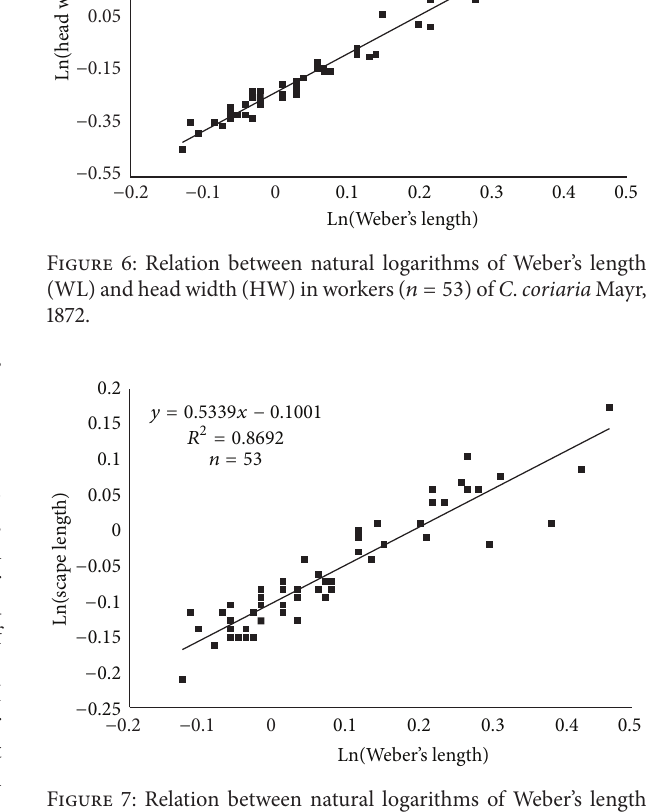
Figure 7: Relation between natural logarithms of Weber’s length (WL) and scape length (SL) in workers ( 𝑛 = 53 ) of C . coriaria Mayr,